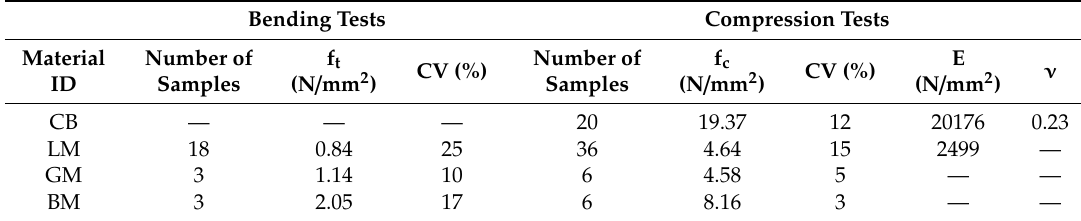
Table 3. Experimentally measured mechanical properties of materials.